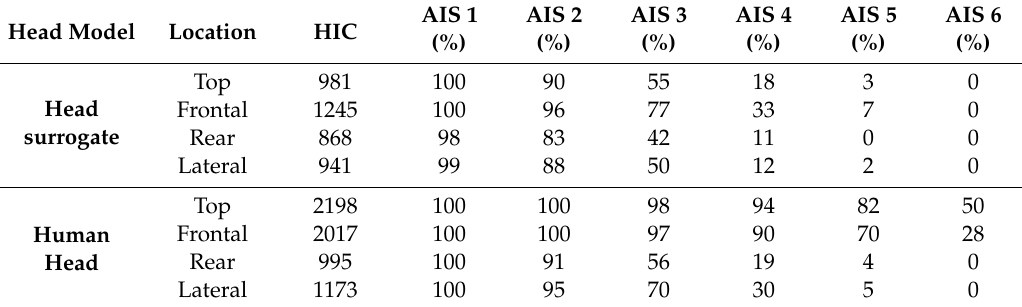
Table 7. HIC and AIS results.